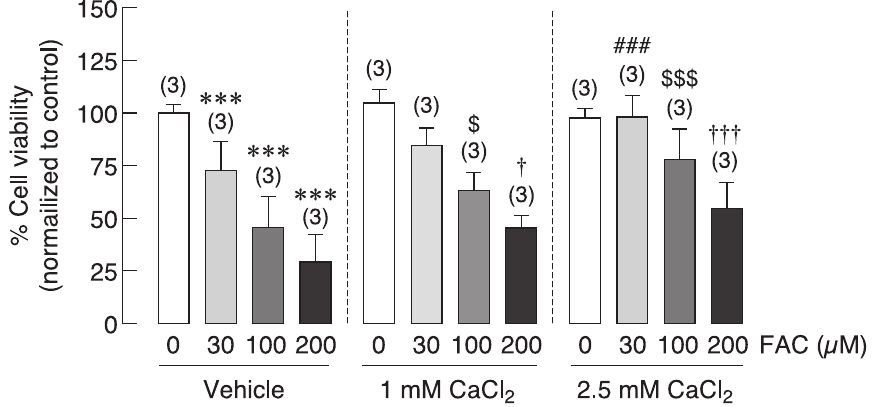
Fig 7. Effects of extracellular CaCl 2 on UMR-106 osteoblast cell survival under iron overload with FAC were illustrated. Osteoblast cell viability was significantly improved ��� P < 0.001 as compared to control group (0 μ M) with vehicle control; ### P < 0.001 as compared to 30 μ M FAC in vehicle control group; $ P < 0.05, $$$ P < 0.001 as compared to 100 μ M FAC in vehicle control group; † P < 0.05, ††† P < 0.001 as compared to 200 μ M FAC in vehicle control group.